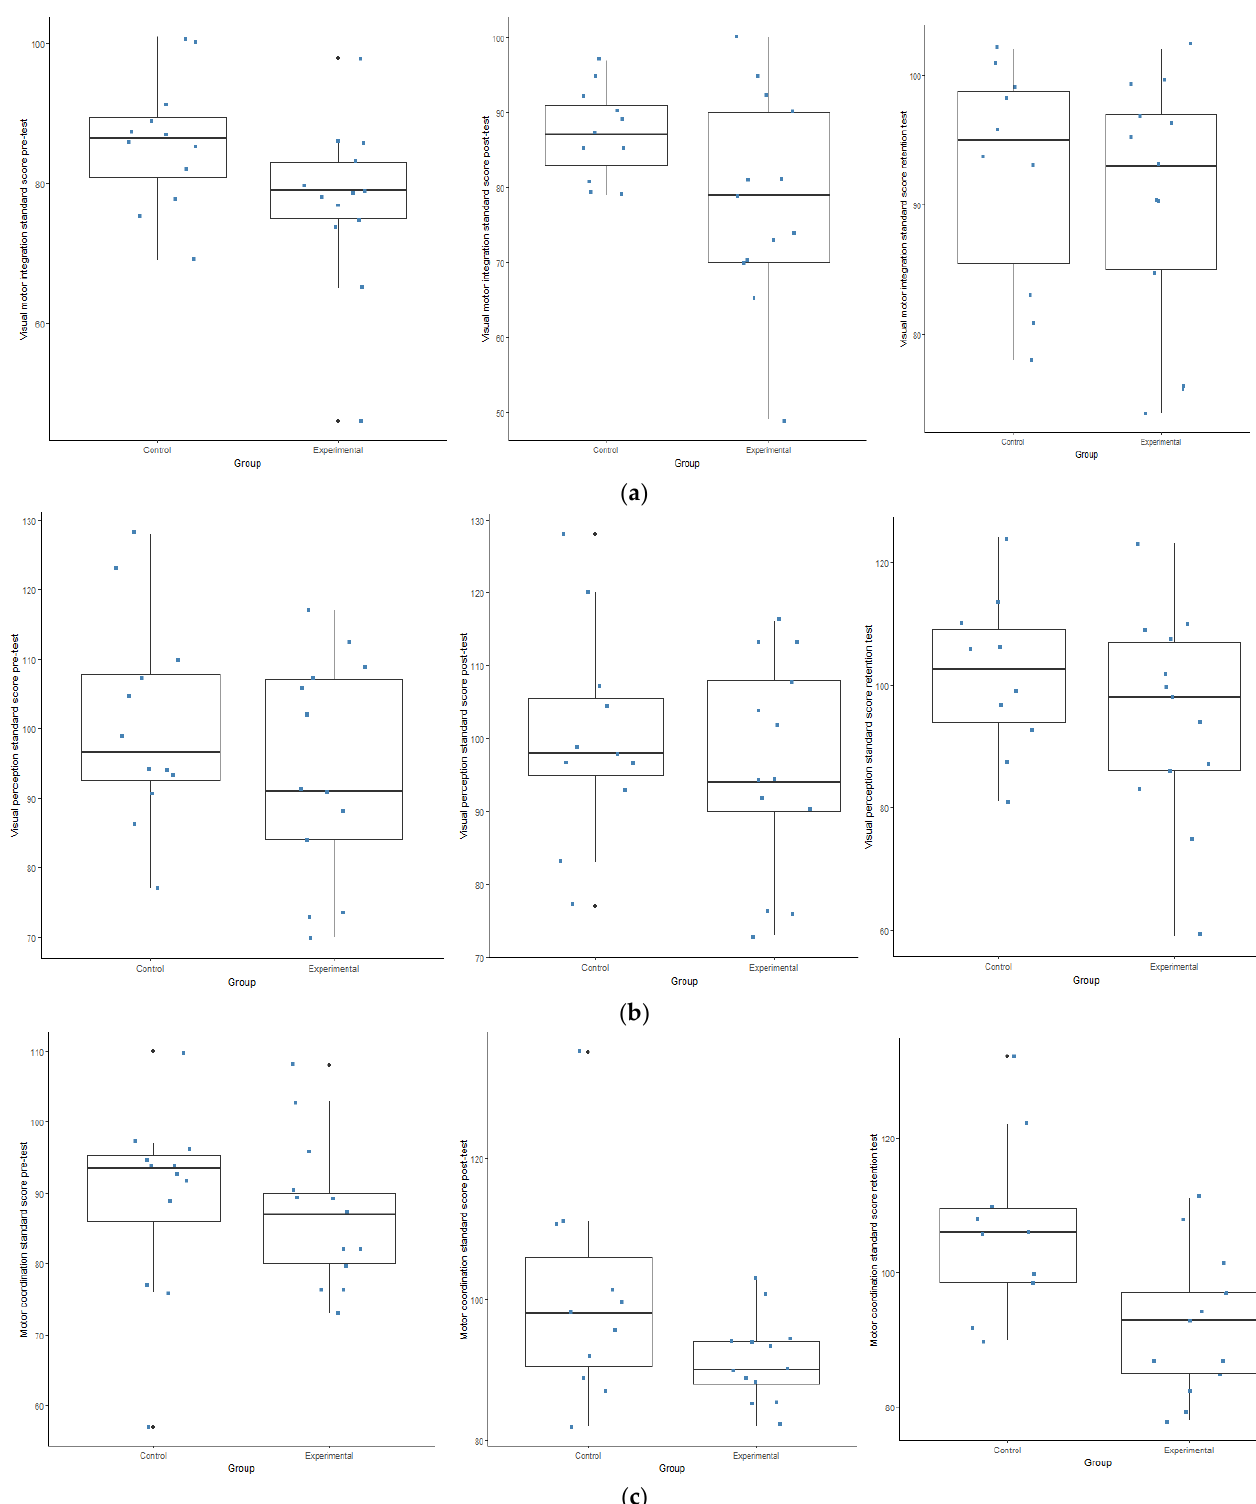
Figure 3. ( a – c ) Box plots indicate the interaction within the control and experimental groups during the Beery Visual–Motor Integration (VMI-4) test. ( a ) Box plots indicating the interaction within the groups during the pre-; post and retention test during the visual–motor integration test. ( b ) Box plots indicating the interaction within the groups during the pre-; post and retention test during the visual perception test. ( c ) Box plots indicating the interaction within the groups during the pre-; post and retention test during the motor coordination